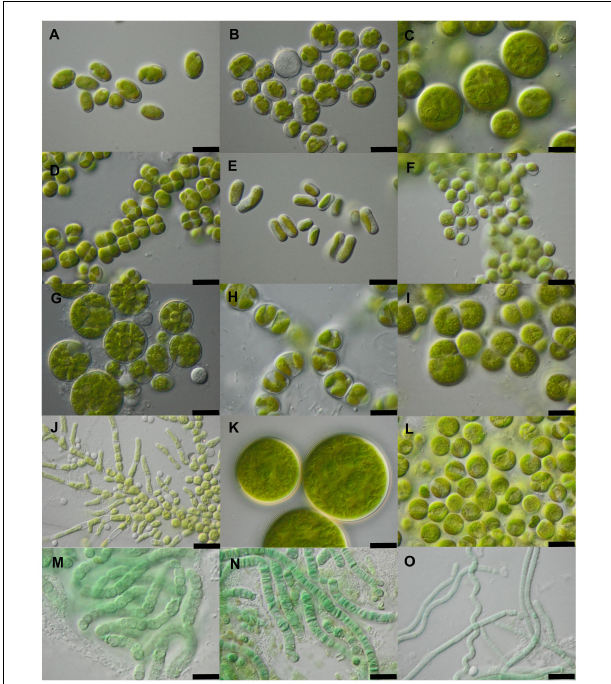
FIGURE 7 | Green algae and cyanobacteria isolated from biocrusts in potash tailings pile areas. (A) Chloroidium ellipsoideum (WT-1); (B) Parietochloris cohaerens (NN-4); (C) Spongiochloris excentrica (TT-5); (D) Diplosphaera chodatii (NN-5); (E) Stichococcus allas (NN-4); (F) Chlorella sp. 1 (SY-1); (G) Borodinellopsis texensis ; (H) Ulothrix aequalis (TT-3); (I) Planophila laetevirens (OD-2); (J) Pseudendoclonium sp. (TT-5); (K) Bracteacoccus minor (OD-3); (L) Myrmecia bisecta (TT-3); (M) Nostoc sp. (SY-1); (N) Pseudophormidium edaphicum (NN-8); (O) Leptolyngbya sp. (NN-5). Scale bars indicate 10 µ m (A–N) , and 20 µ m (O) .